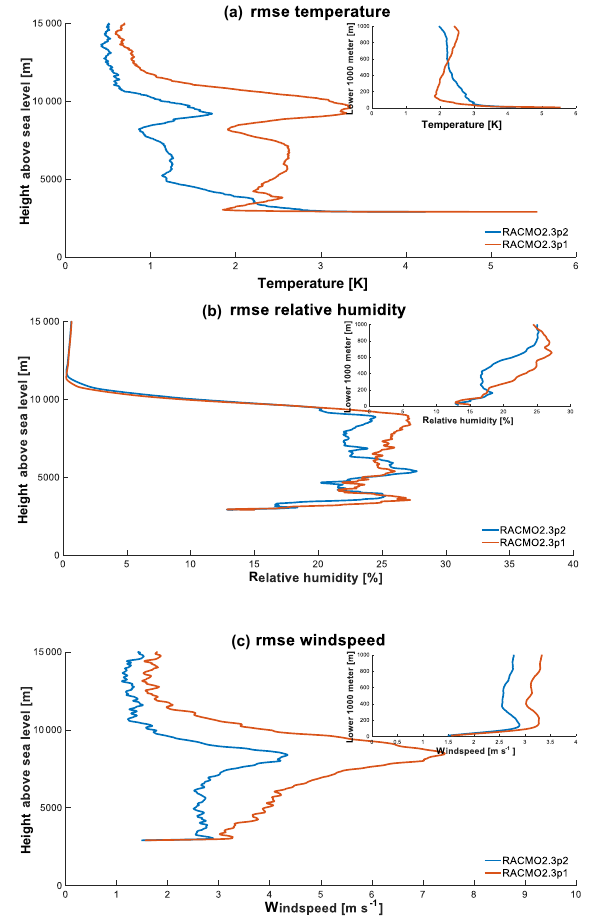
Figure 7. Root mean square error (RMSE) of average upper- atmosphere temperature (a) , relative humidity (b) and wind speed (c) from RACMO2.3p2 (blue) RACMO2.3p1 (red) and the radiosonde observations at Kohnen Station, from January 2014. Note that the lowermost level is at the surface of Kohnen Sta- tion, at ∼ 3000m elevation. Subpanels show a close-up of the lower 1000m.